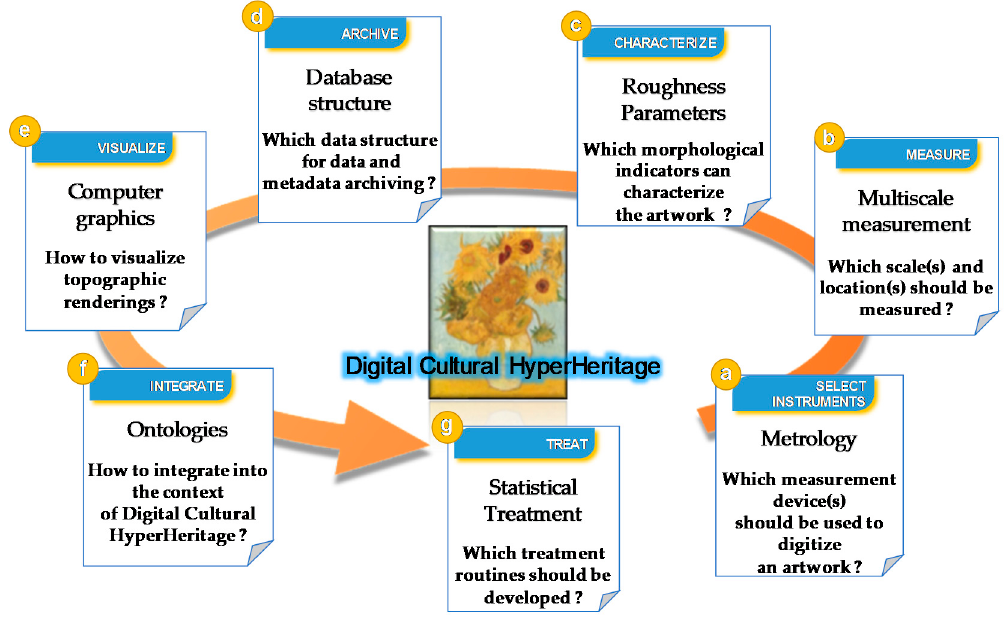
Figure 1. Conception of the Digital Surface HyperHeritage approach.